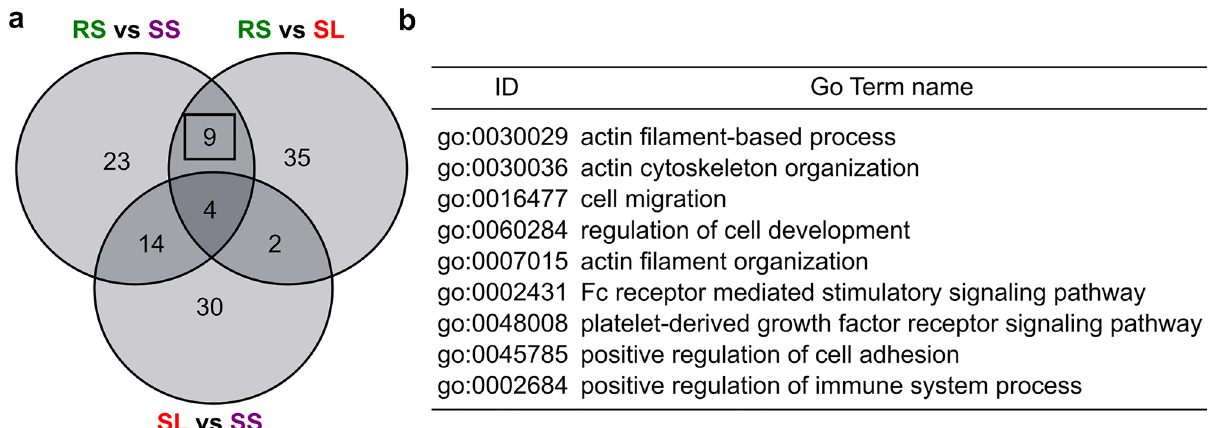
Figure 3. Gene ontology set analysis. ( a ) Venn diagram showing the overlap of GO terms that were enriched in DEGs identified in RS vs SS, RS vs SL and SL vs SS. ( b ) Common GO terms only between RS vs SS and RS vs SL. RS, Resistant from sea; SS, Susceptible from sea; SL, Susceptible from